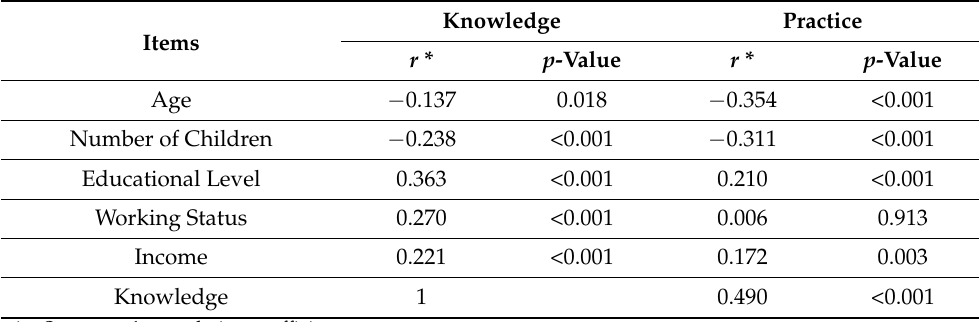
Table 2. Correlation between sociodemographic characteristics and mothers’ knowledge and man- agement practices of fever, and correlation between mothers’ knowledge and practice.